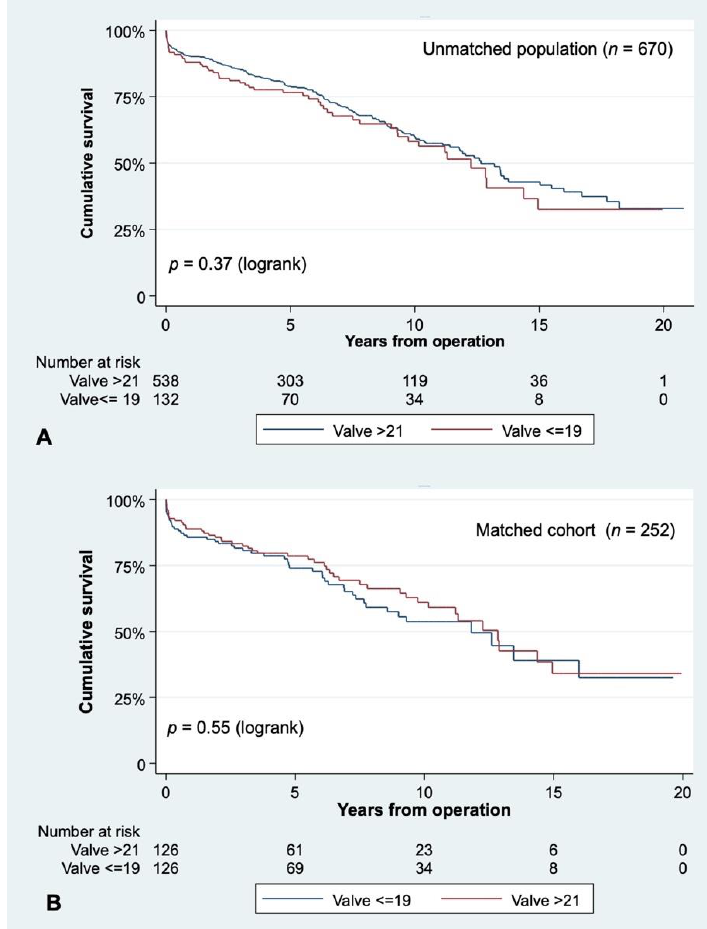
Figure 2. Cumulative survival for the unmatched ( A ) and matched cohorts ( B ), according to valve size.